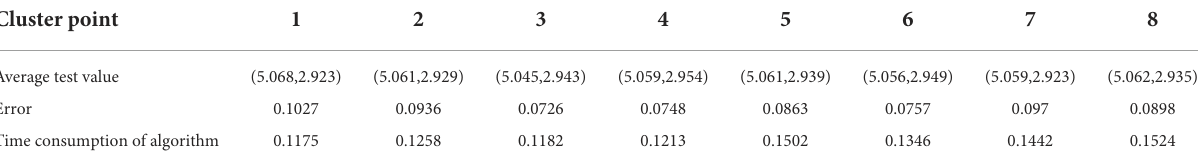
TABLE 1 Optimization efficiency of FCM algorithm under different clustering conditions. Cluster